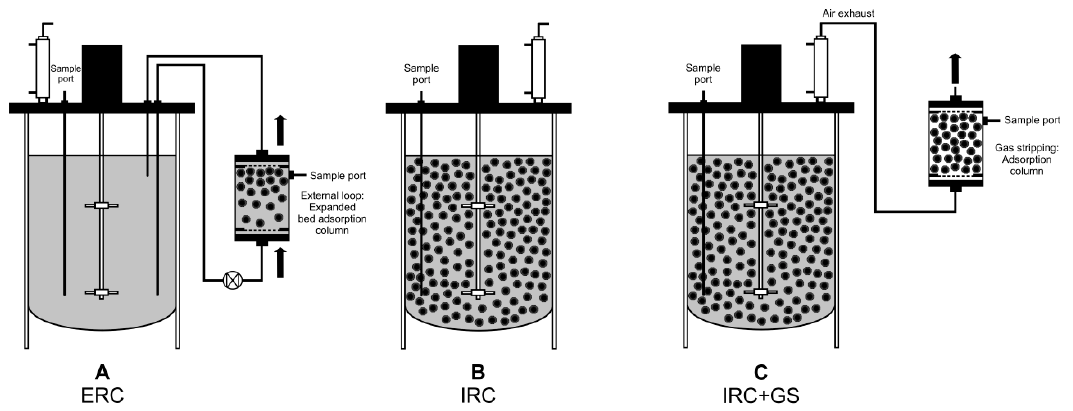
Figure 6. Diagram with the distinct bioreactor configurations used for the in situ recovery of (+)-zizaene. ( A ) External recovery: Adsorbers in expanded bed adsorption (EBA) column by an external loop. ( B ) Internal removal: Adsorbers inside the bioreactor vessel. ( C ) Internal removal with gas stripping: Adsorbers inside the bioreactor vessel and adsorption column coupled to the off-gas. Sample ports for adsorbers are indicated.